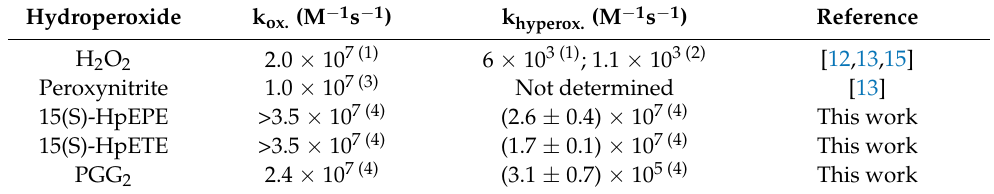
Table 3. Kinetics of Hs Prx3 oxidation and hyperoxidation by biologically relevant hydroperoxides.